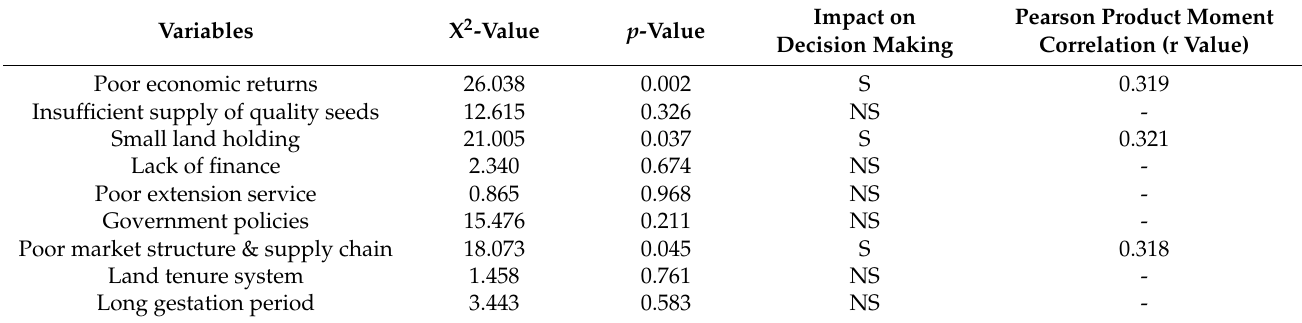
Table 6. Chi-square Analysis of Constraints and Impact on Decision Making to Establish Forest Plantations. Variables X 2 -Value p -Value